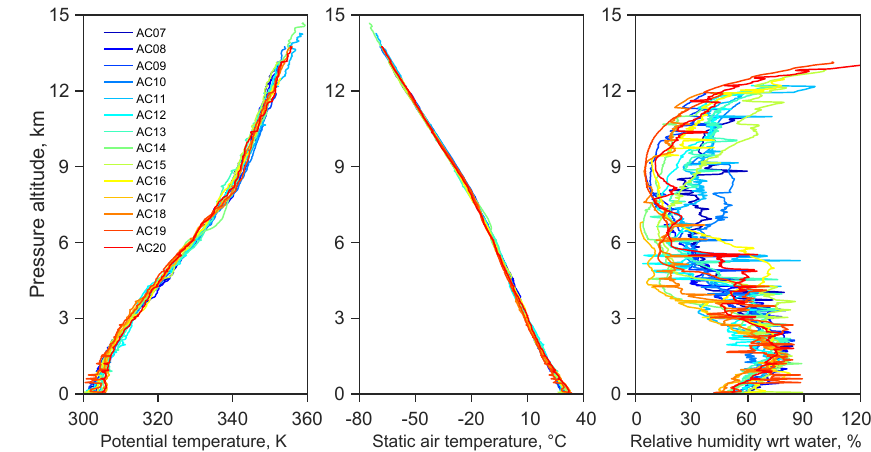
Figure 5. Vertical profiles of potential temperature, static air temperature, and relative humidity measured on HALO during the ACRIDICON–CHUVA flights over the Amazon Basin.